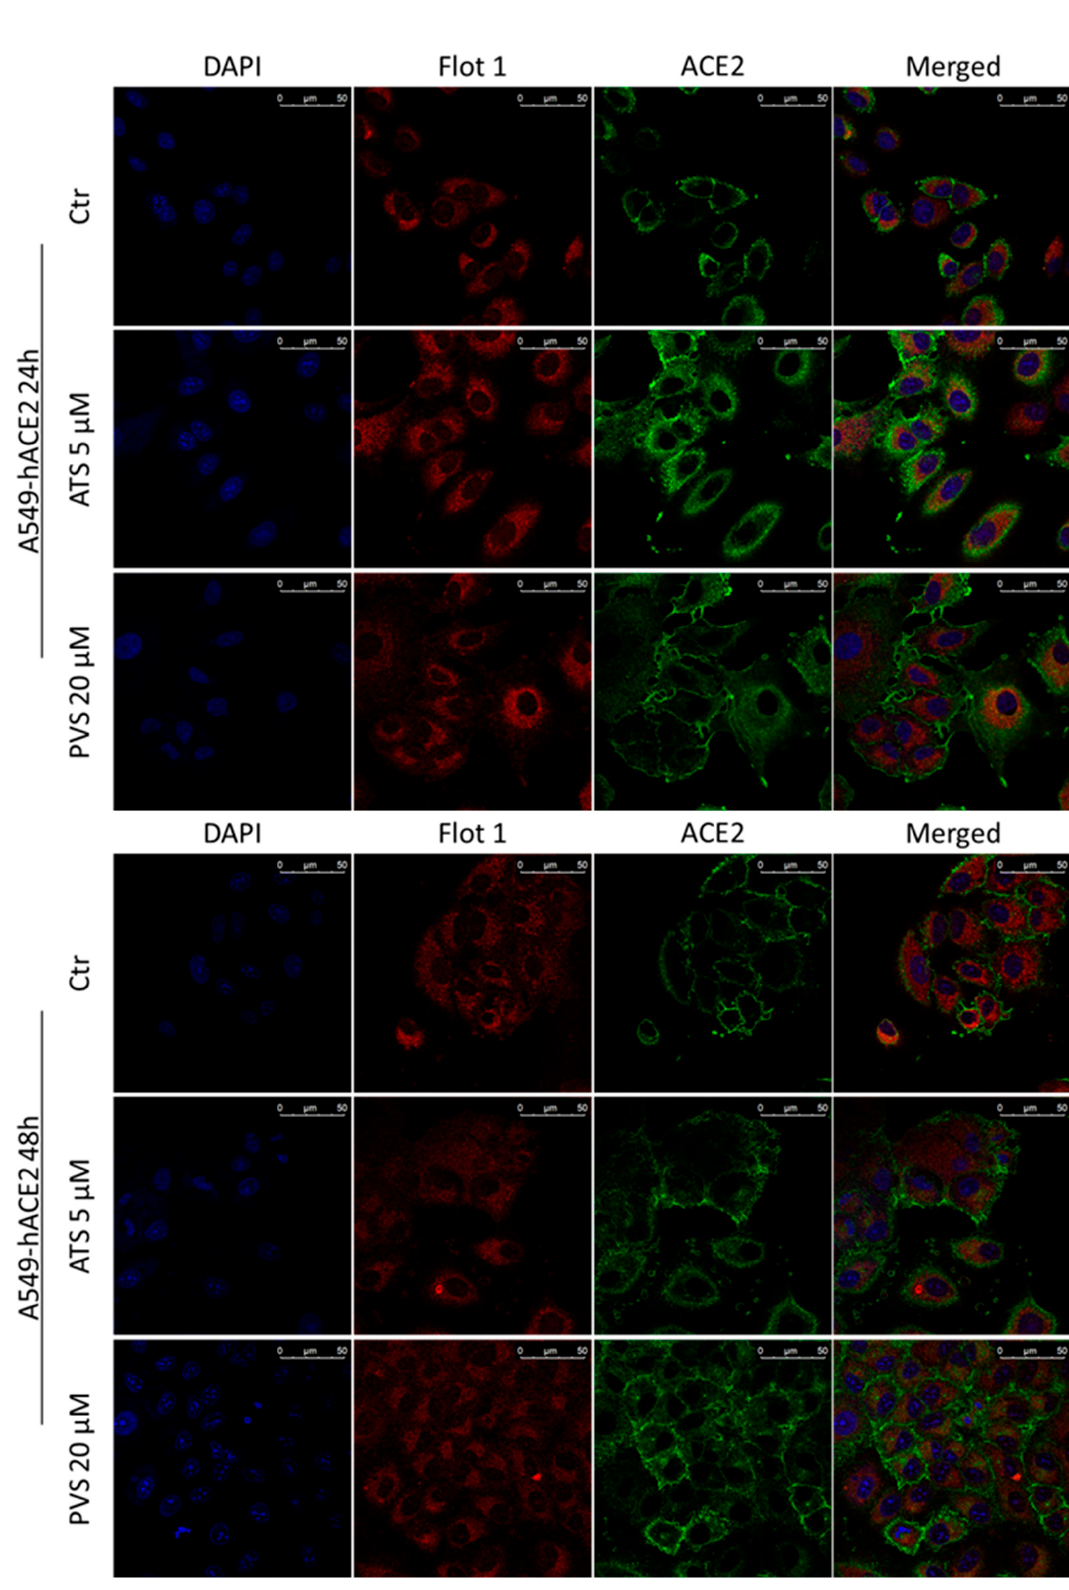
Figure 6. Representative confocal microscopy images of Flotillin-1 (red) and ACE2 receptor (green) in A549-hACE2 cells treated with ATS or PVS at indicated doses and time points. Nuclei were stained with DAPI (blue fluorescence). Scale bar 50 µm.